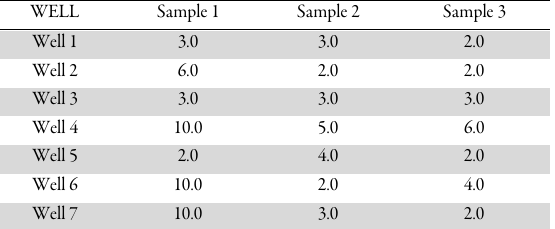
Table 5. Biofilm cell formation unit (n x 10 3 cfu/ml)